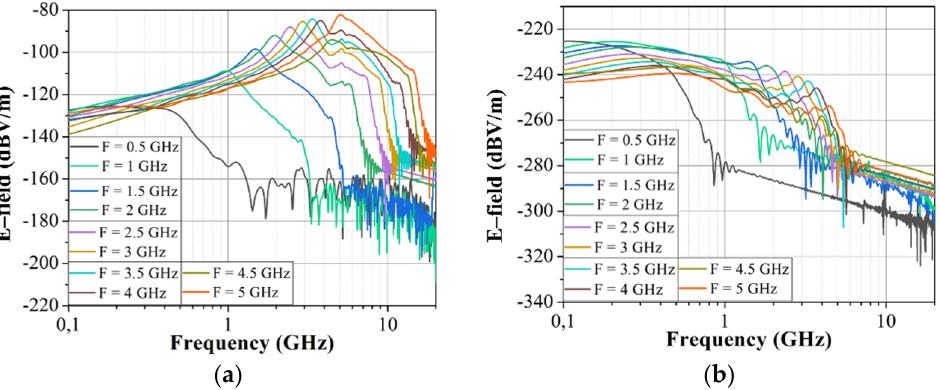
Figure 14. ( a ) Frequency spectrum of E– field measured near PCB without shielding. ( b ) Frequency spectrum of E– field measured with single 6 µm – Cu layer shielding enclosure. Measurements are presented for the 10 half–wave dipolar